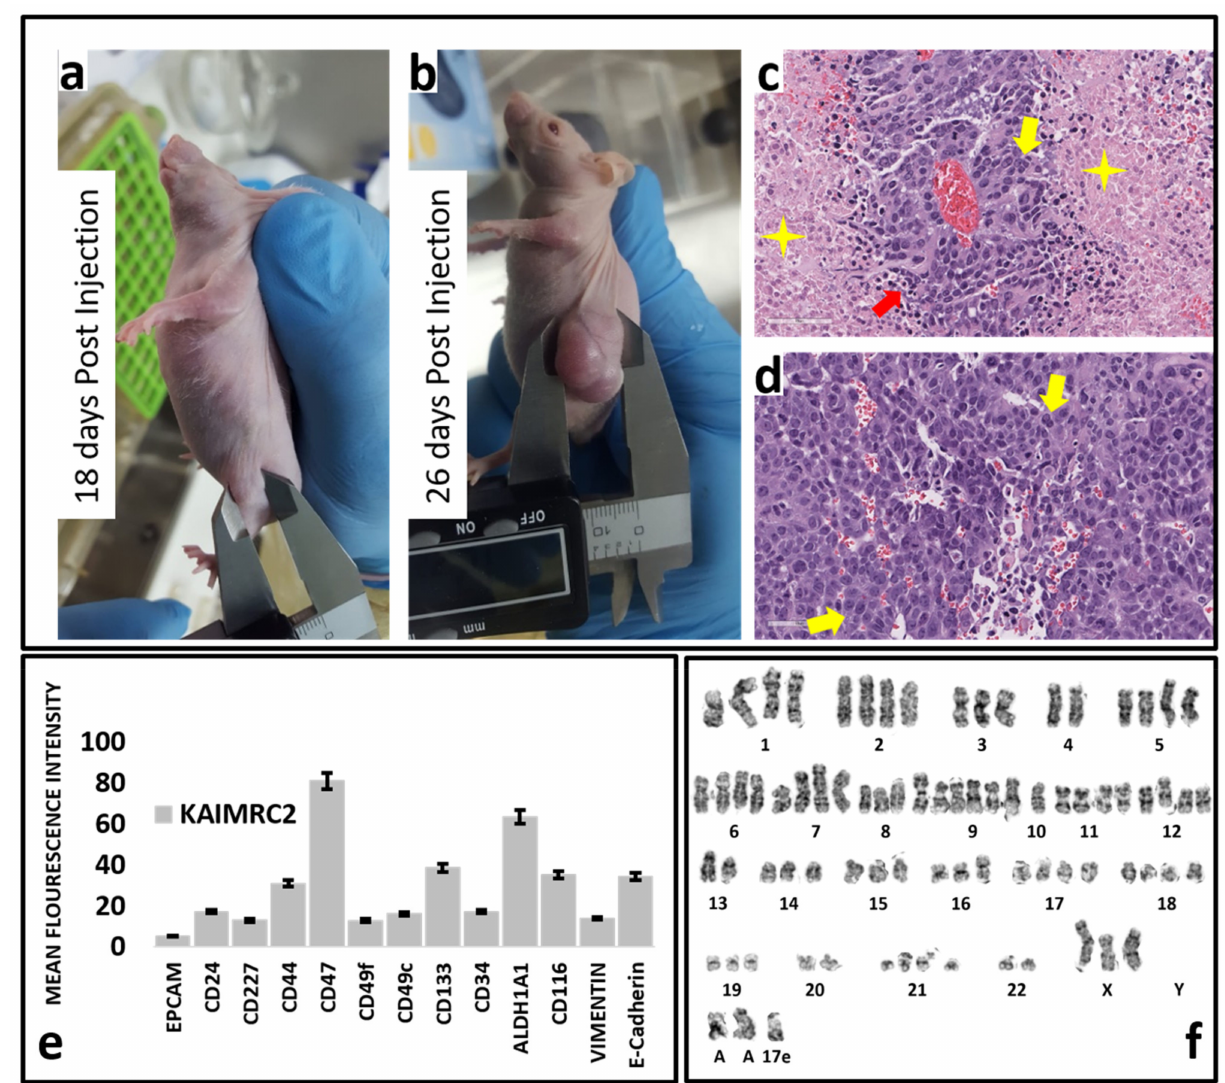
Figure 6. Determination of tumorigenicity potential of the KAIMRC2 cell line. ( a ) Image of nude mice after 18 days of injection. A noticeable tumor lump is visible. ( b ) Image of the same mice on the 26th day. A big lump of the tumor is visible. The mouse was sacrificed on the same day, and the tumor was isolated and stained. ( c , d ) H&E staining of a histological section of the isolated tumor. Cells exhibit all the hallmarks of malignancy, i.e., nuclear pleomorphism, hyperchromasia, clumped nuclear chromatin, and mitoses (yellow arrows). Focal tumor necrosis is also present (Yellow 4-point star). Extensive tumor coagulative necrosis and the concentration of viable cancer cells can be seen around the blood vessels, i.e., Peritheliomatous necrosis (red arrows), a hallmark of the high-grade tumor. Scale bar = 50 µ m. ( e ) Flow cytometric analysis of selected breast cancer and CSCs markers expressed on the KAIMRC2 cell line. ( f ) Representative karyograph of KAIMRC2 cell line. It revealed the presence of an abnormal, complex, and composite karyotype including chromosome range of 58–79; hexasomy of chromosome 9, tetrasomy of chromosomes 1, 2, 5, 6, 7, 11,12, 17, 18 and 21; trisomy of chromosomes 3, 8, 14, 15, 16 and 19. Genomic instability and the existence of heterogeneity in the KAIMRC2 cell line is represented by these chromosomal